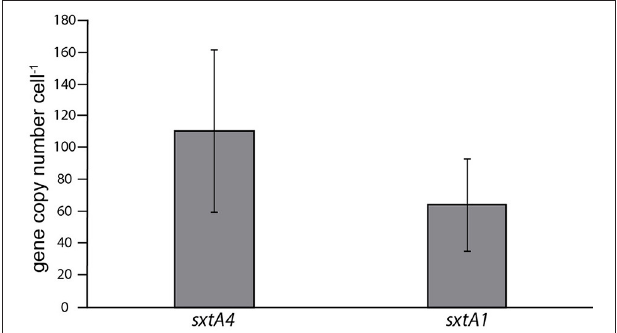
FIGURE 4 | Average gene copy number cell − 1 of domains sxtA4 and sxtA1 in G. catenatum